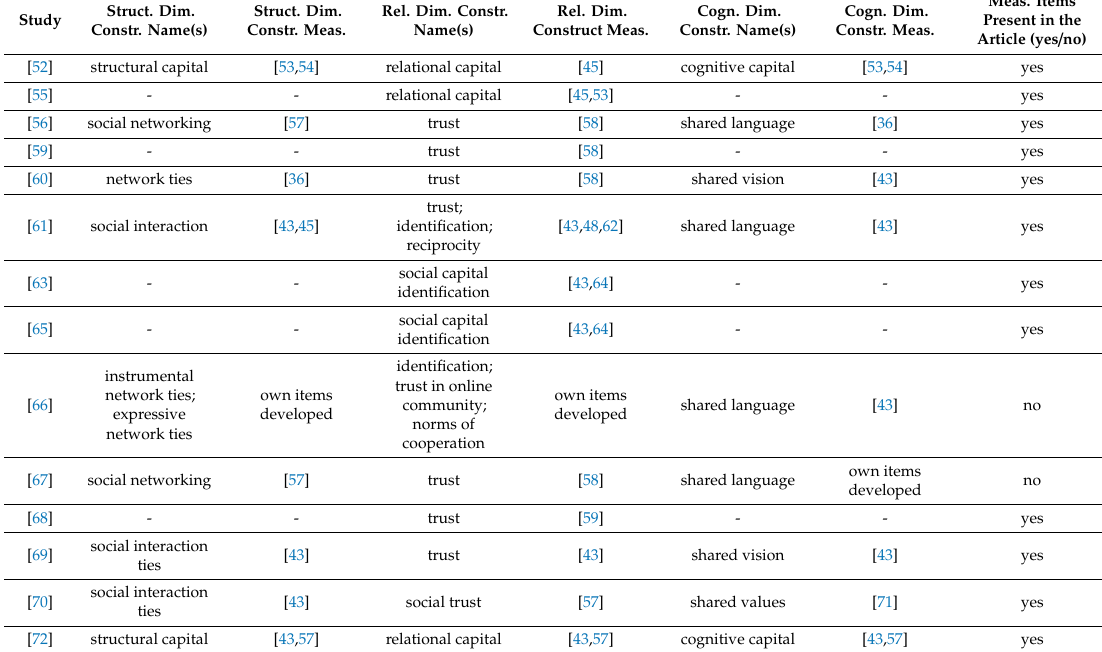
Table 3. Evaluation of the 15 items (19%) of the final set of publications operationalizing social capital measurement constructs according to the multidimensional view. Abbreviations used: struct. = structural, dim. = dimension, constr. = construct, meas. = measurement(s), rel. = relational, cogn. = cognitive.